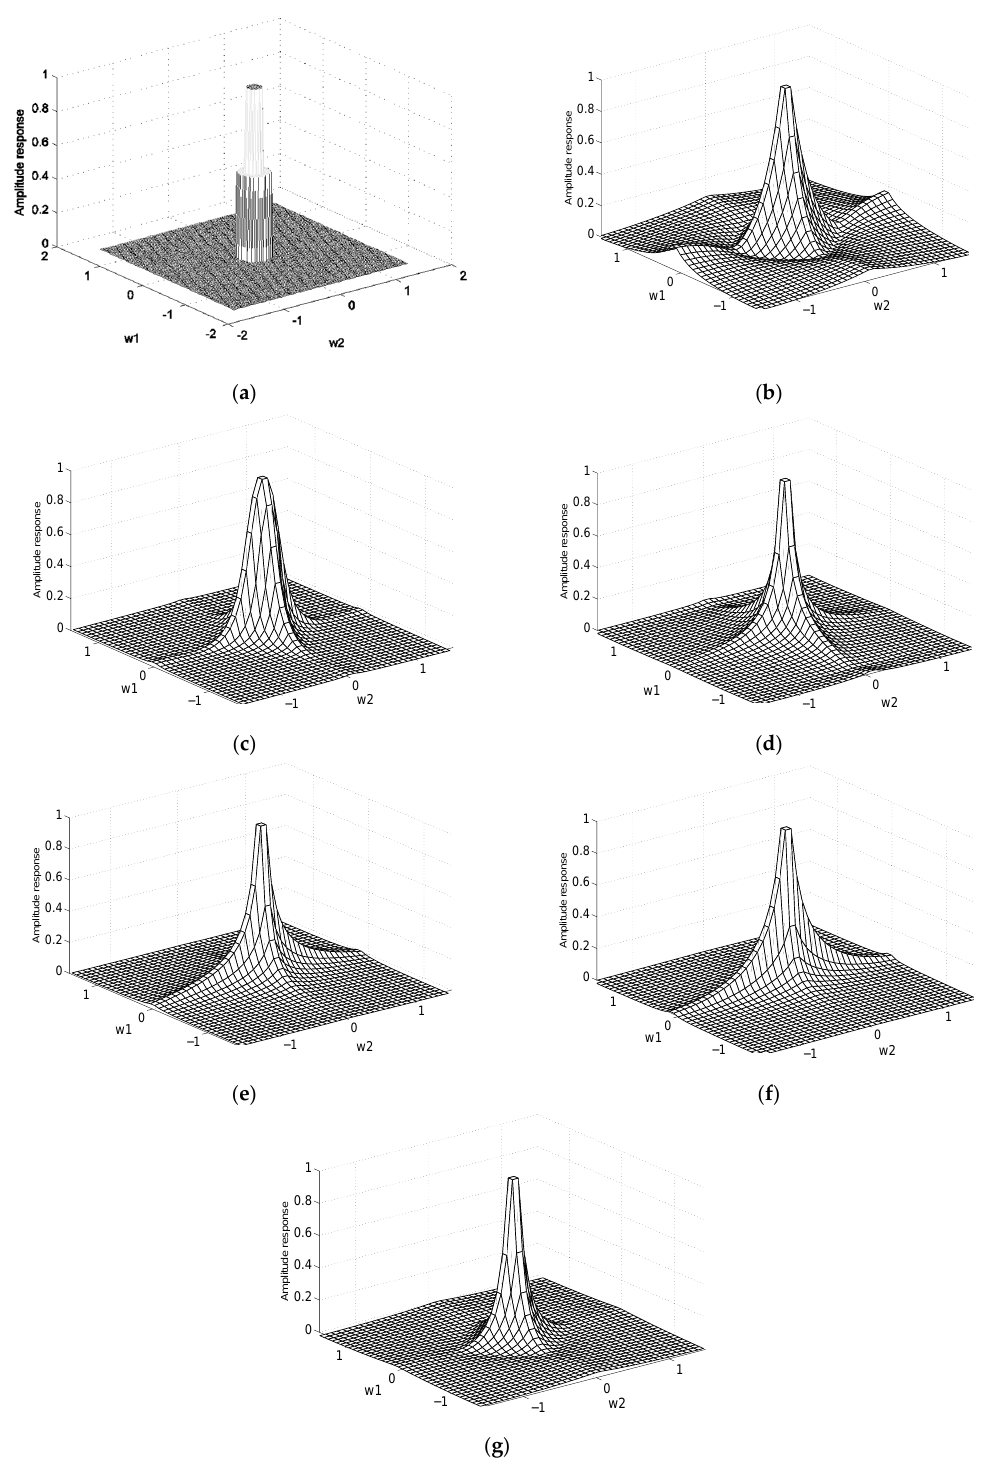
Figure 2. ( a ) Desired amplitude response, ( b ) Amplitude response calculated by PSO, ( c ) Amplitude response calculated by ABC, ( d ) Amplitude response calculated by DE, ( e ) Amplitude response calculated by HS, ( f ) Amplitude response calculated by GSA, ( g ) Amplitude response calculated by